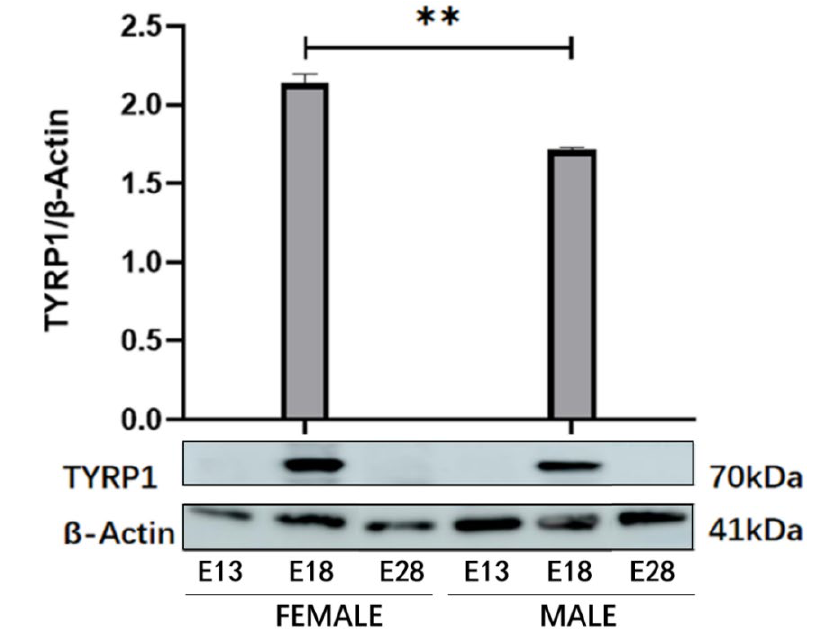
Figure 8. Protein expression trend of TYRP1 in the embryonic dorsal skin feather follicles of Holdobaggy geese using Western blot. Note: ** Significant difference ( p < 0.01). Each sample is shown as mean ± SEM. The upper panel shows the measurable quantities of TYRP1 in dorsal skin feather follicles at different growth stages of male and female geese. The lower panel indicates the β -actin as an internal control in all samples. Full Western Blot Figures are provided in the supplementary